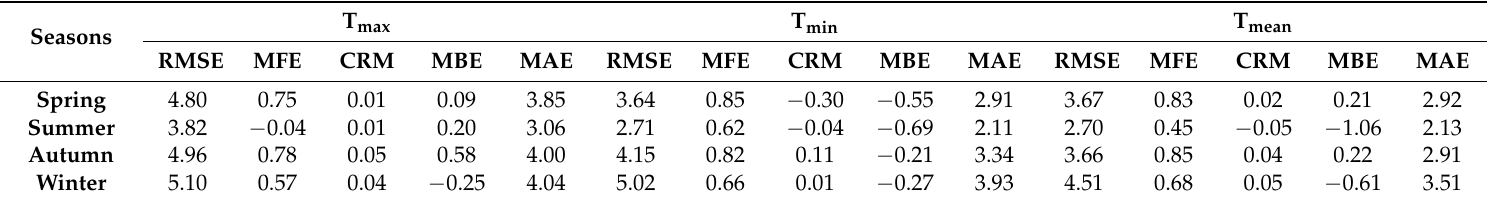
Table 4. The performance of optimal models for T max , T min , and T mean in different seasons. Model accuracy is given by RMSE, MEF, CRM, MAE, and MBE. Seasons